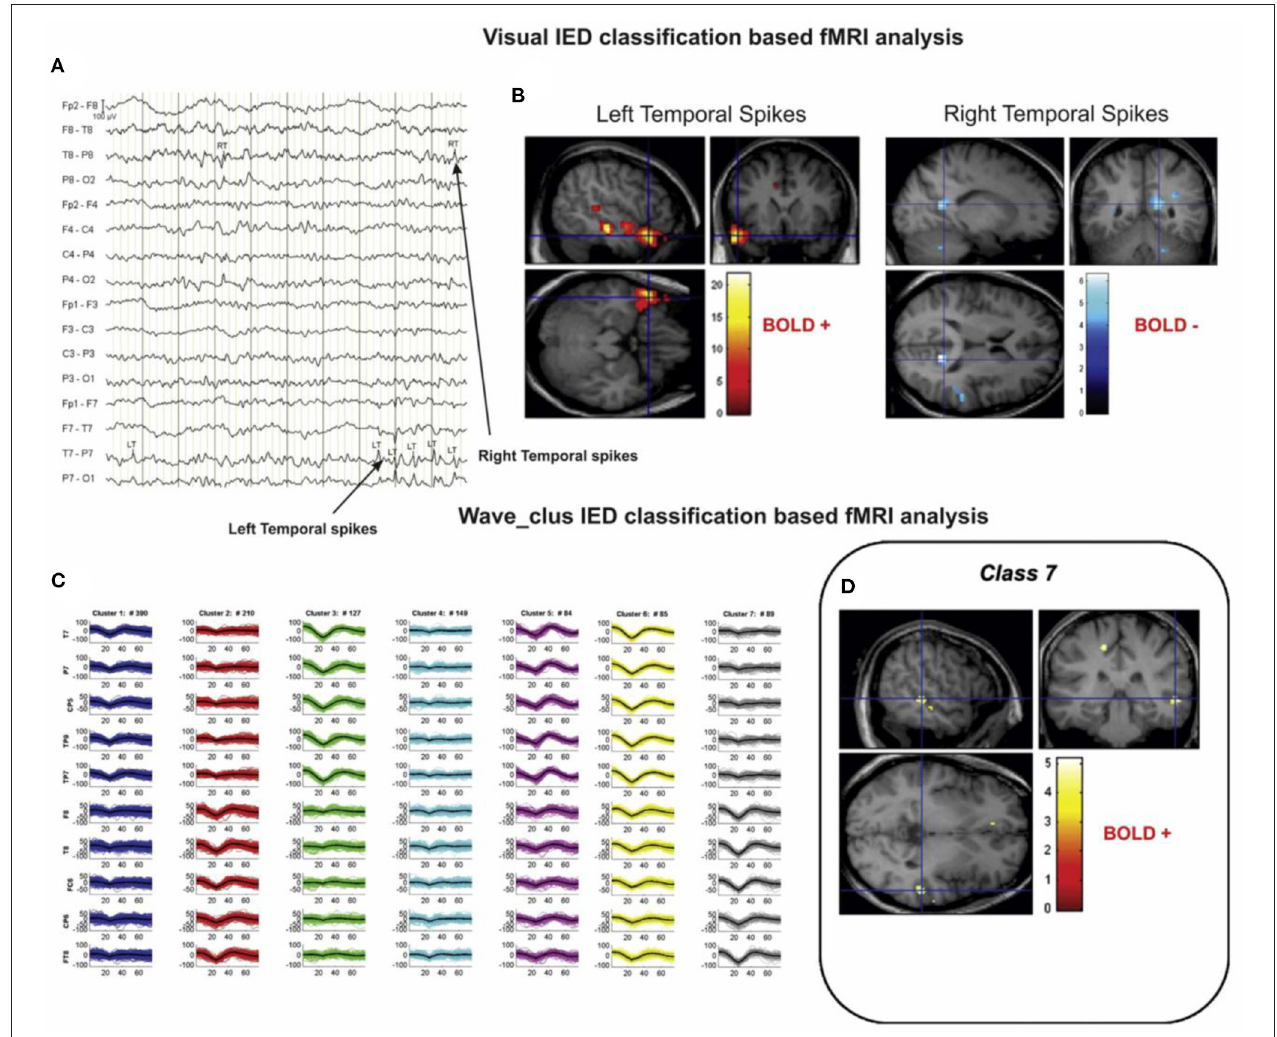
FIGURE 3 | A sample of visual and algorithmic classification of the IEDs. (A) The result of visual classification from the bipolar montage (64 channels) of EEG recorded inside the scanner is performed by an expert. (B) The results of EEG–fMRI analysis, based on visual-IED labeling. (C) The seven classes identified using the algorithmic classification. (D) The result of EEG–fMRI analysis, associated with class 7 of identified IEDs. All the fMRI results are overlaid on the subject’s T1-weighted image (